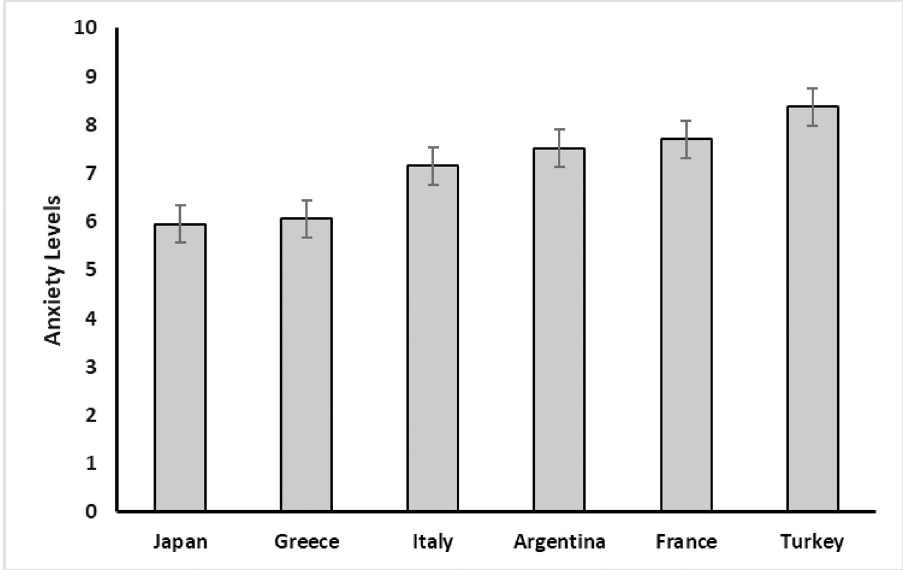
Fig 1. Average anxiety levels in the six studied countries. Whiskers represent the SE of the mean.